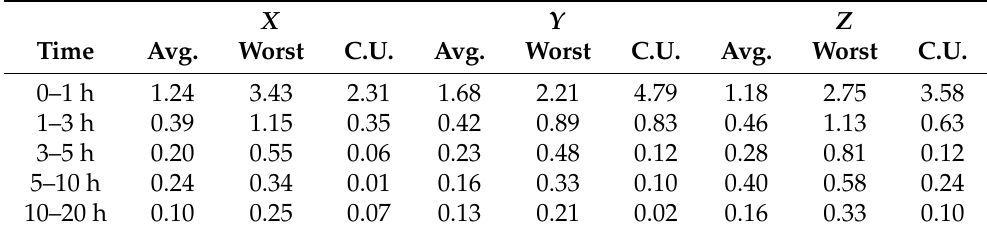
Table 3. Temporal drifts magnitude for each axis (mg/h).